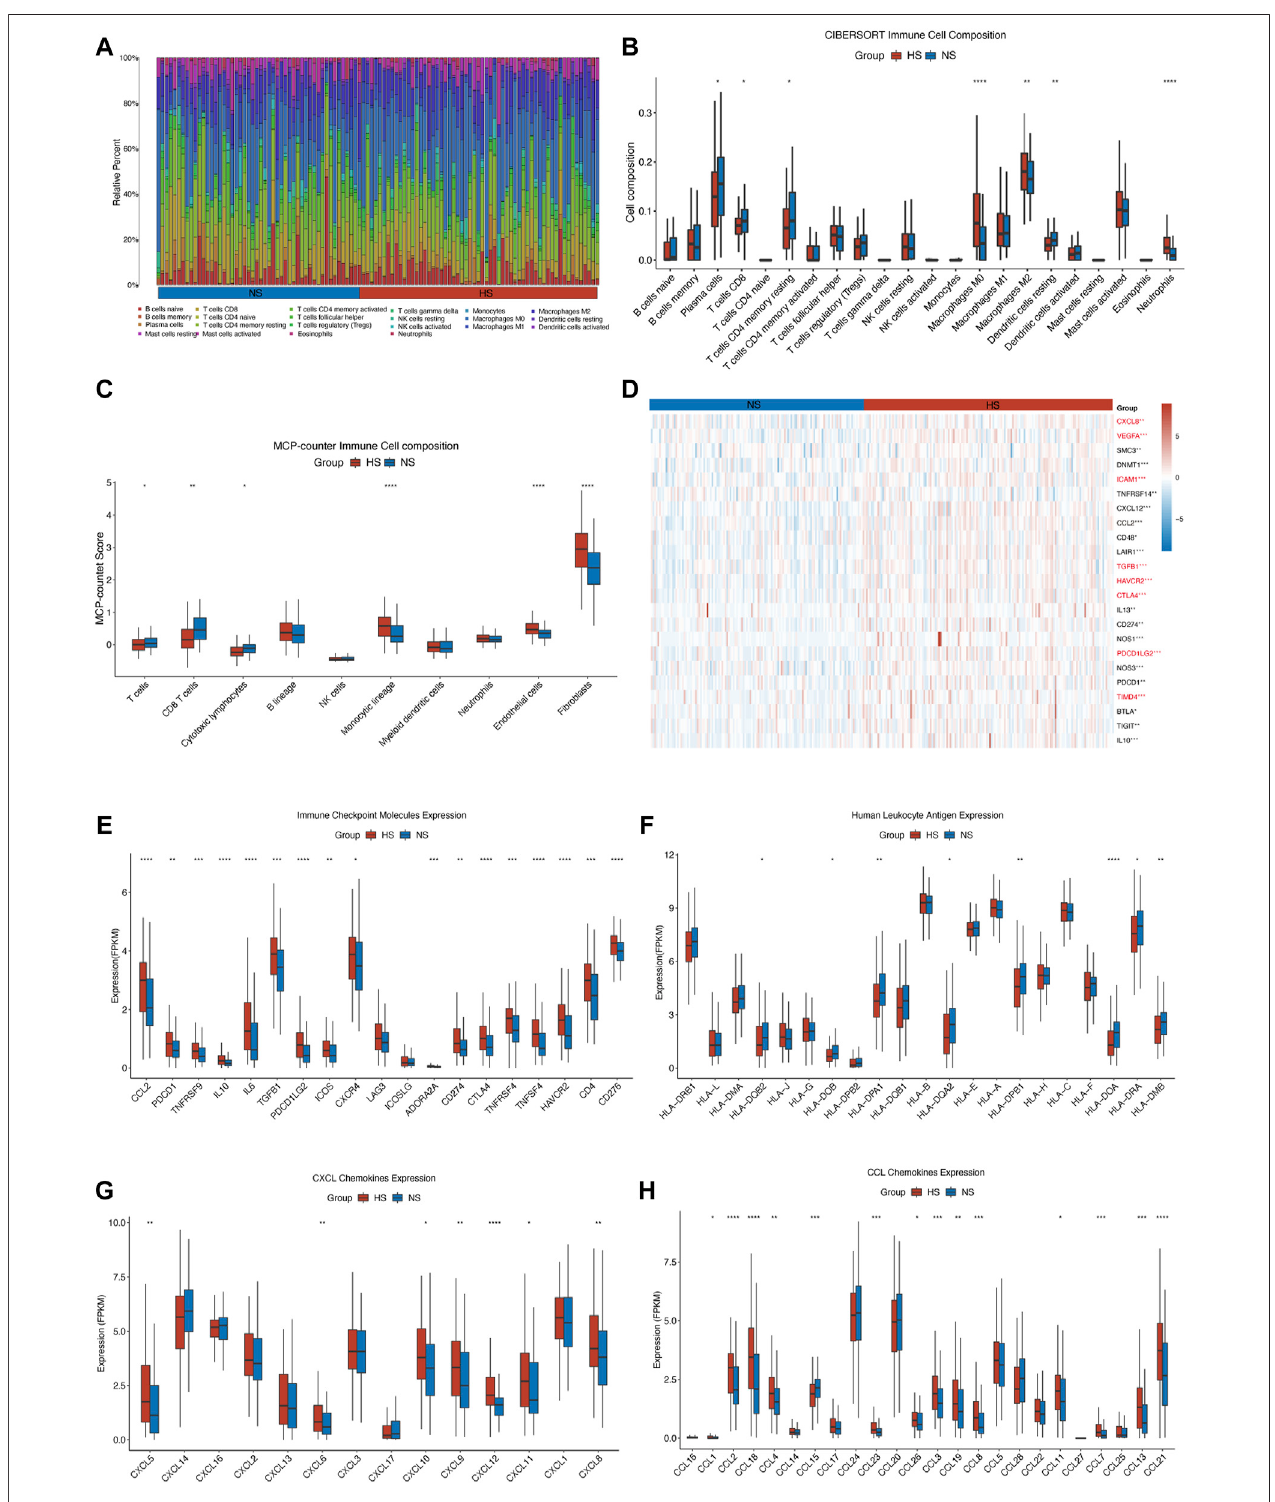
FIGURE 7 | Illustration of different in fi ltration ofimmunecells and expression ofimmune checkpoint molecules and chemokines in NS and HS. In the TCGA-COAD cohort, the stacked bar chart (A) and the grouped bar chart of CIBERSORT analysis (B) showed that a higher level of anti-in fl ammation macrophages (M0 and M2) and neutrophils and a lower level of T cell (especially CD8+ T cell) were in the HS. The result of MCP-counter (C) con fi rmed that T cells, CD8+ T cells, and cytotoxic lymphocytes were enriched in NS, compared with those in HS. It also indicated that the in fi ltration of endothelial cells and fi broblasts was higher in HS. (D) The